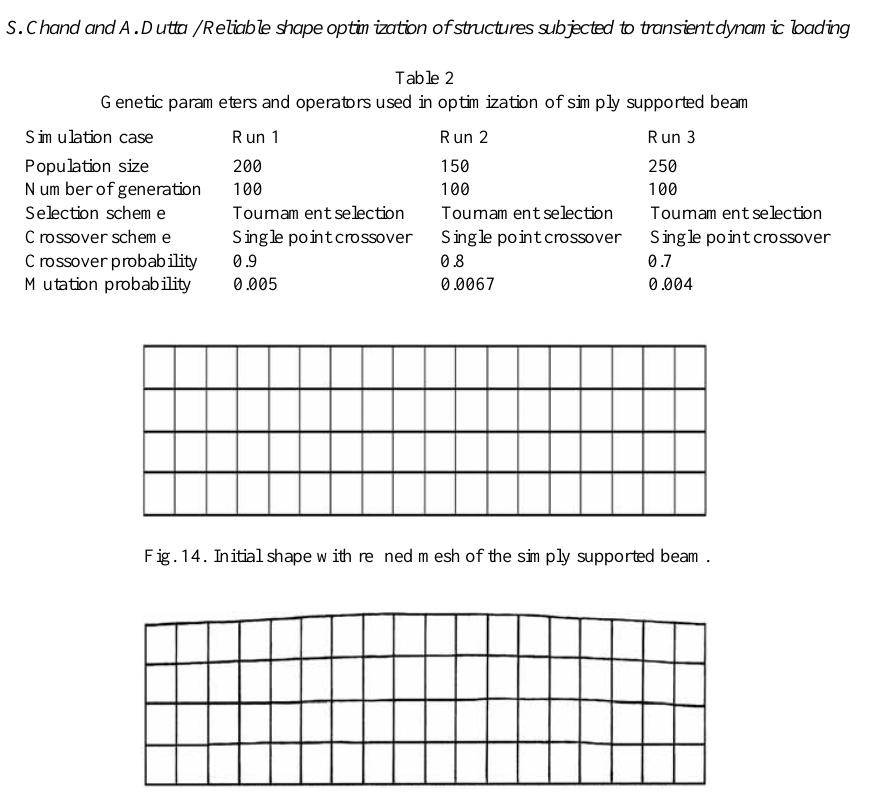
Fig. 15. Final shape of the optimized simply supported